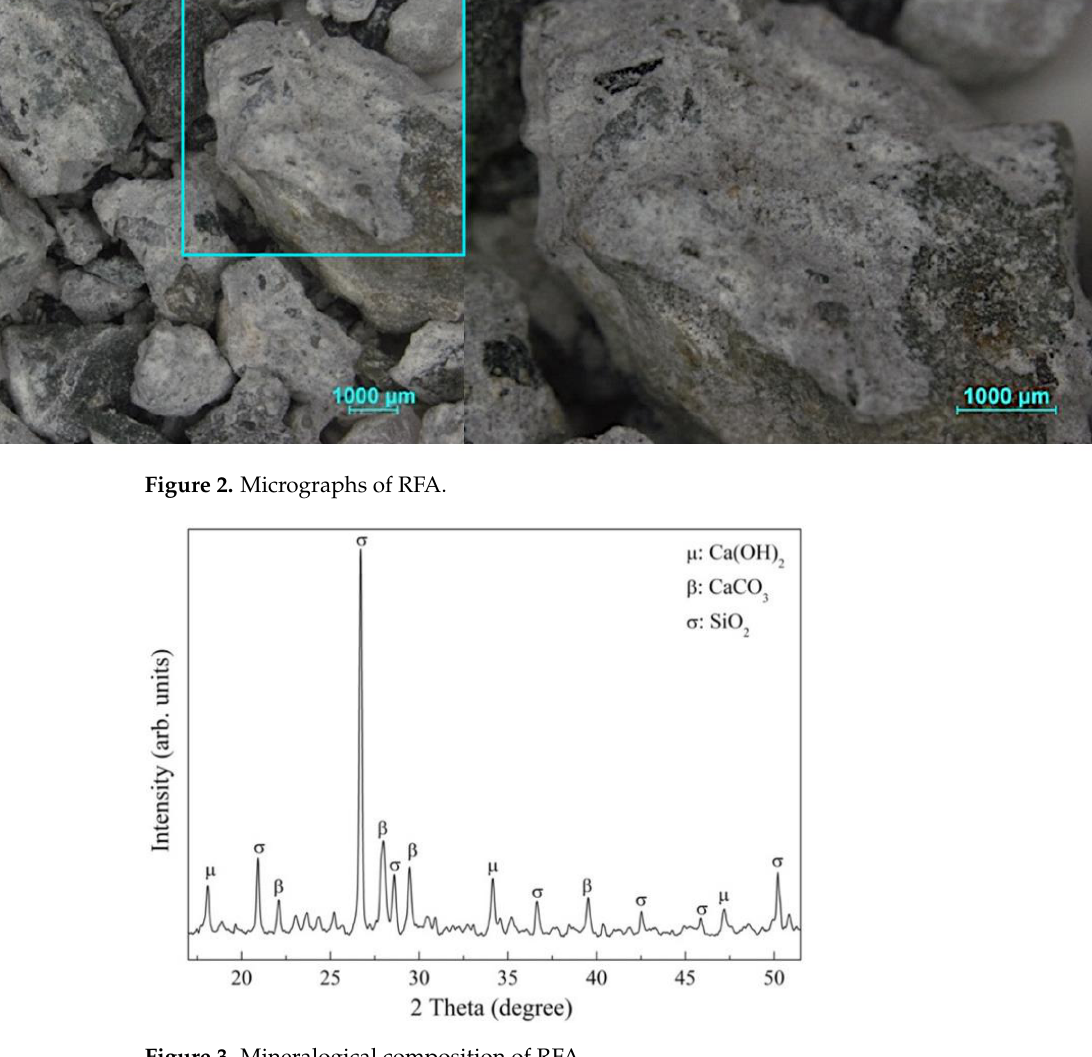
Figure 3. Mineralogical composition of RFA.